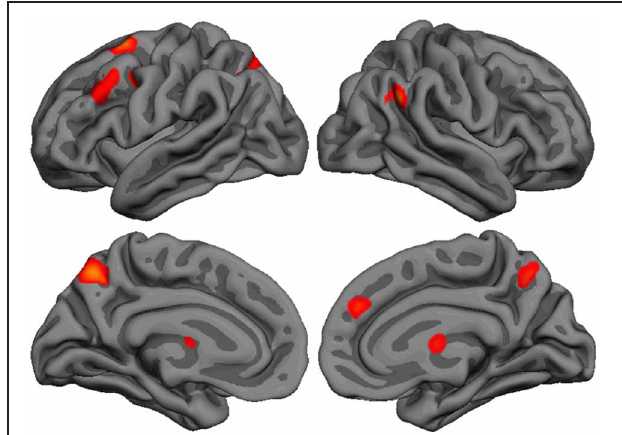
FIGURE 2 | Lateral and medial brain renders (rendered with freesurfer) showing activated clusters ( p < 0 . 05 FWE corrected, k > 25 voxels) for the contrast